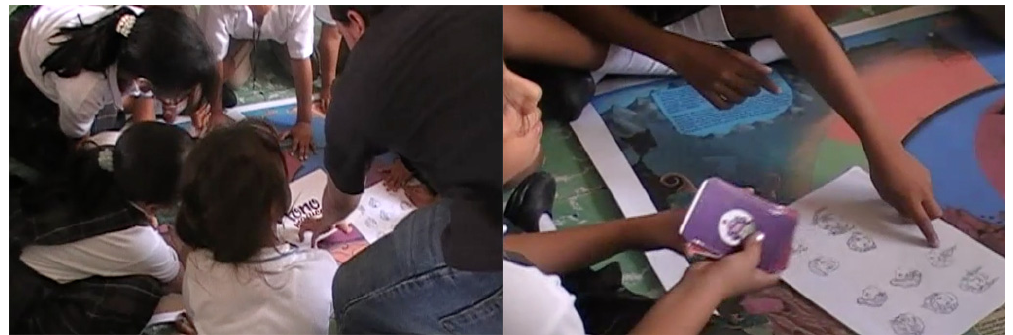
Figure 5. Children participating in the design.